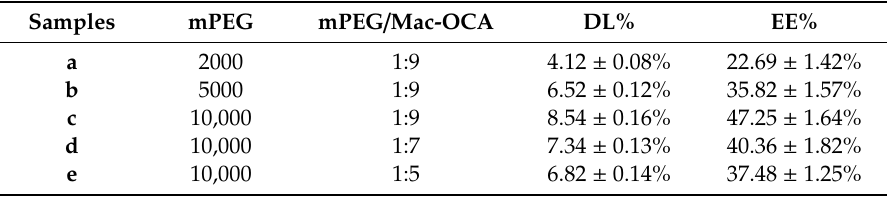
Table 2. Drug loading and entrapment e ffi ciency of di ff erent PNS microspheres. Samples mPEG mPEG / Mac-OCA